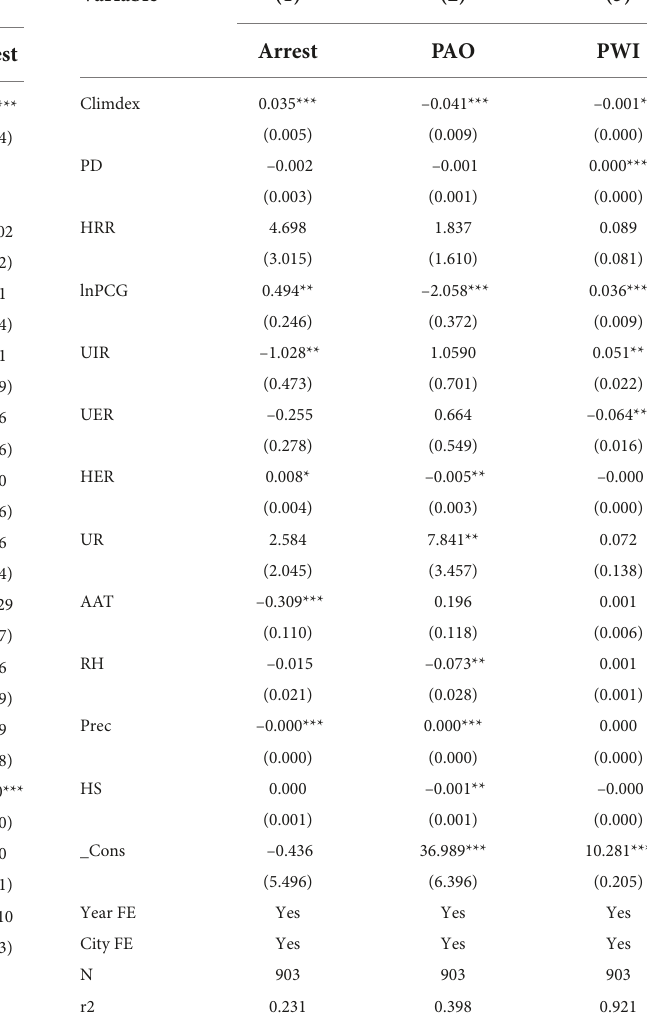
TABLE 5 Robustness test results of regression models. TABLE 6 Mechanism of the effect of climate extremes on crime